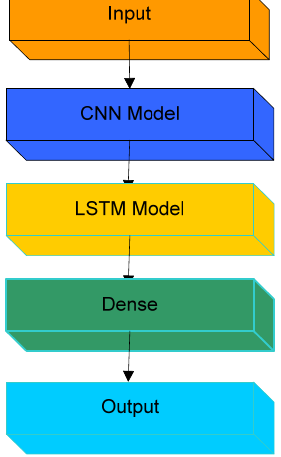
Figure 1. CNN LSTM structure.